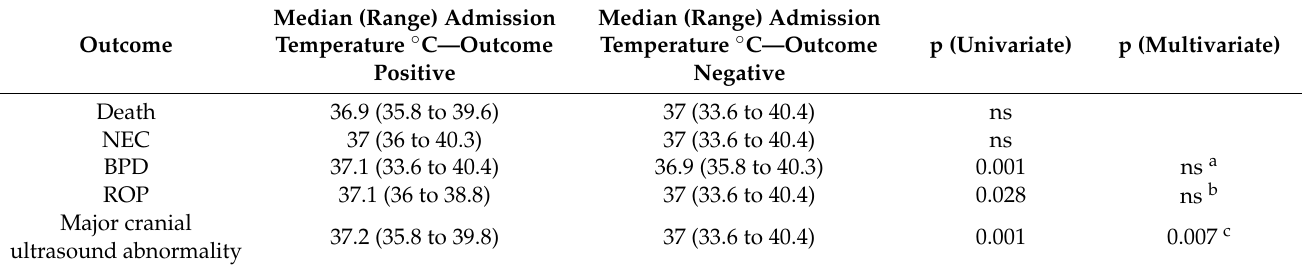
Table 3. Relationships between admission temperature and clinical